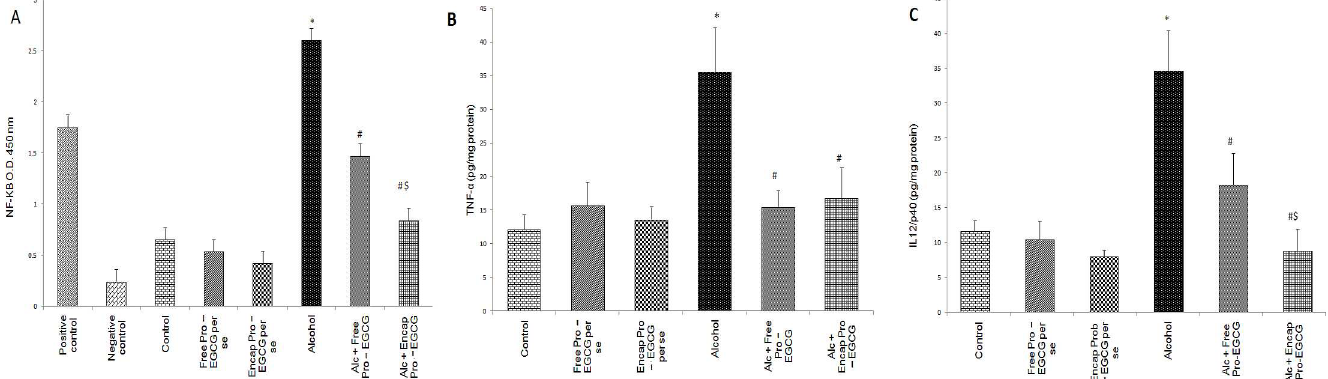
Fig 7. Effect of probiotic- EGCG combination (free and encapsulated) on A) NF- B/p50, B) TNF- α levels, and C) IL-12/p40 levels in alcohol administeredrats with and without treatment. Values are expressedas mean ± S.D. of eight different observations. * p < 0.05vs. control, # p < 0.05vs. alcohol group, $p < 0.05vs. alc+ free pro-EGCG